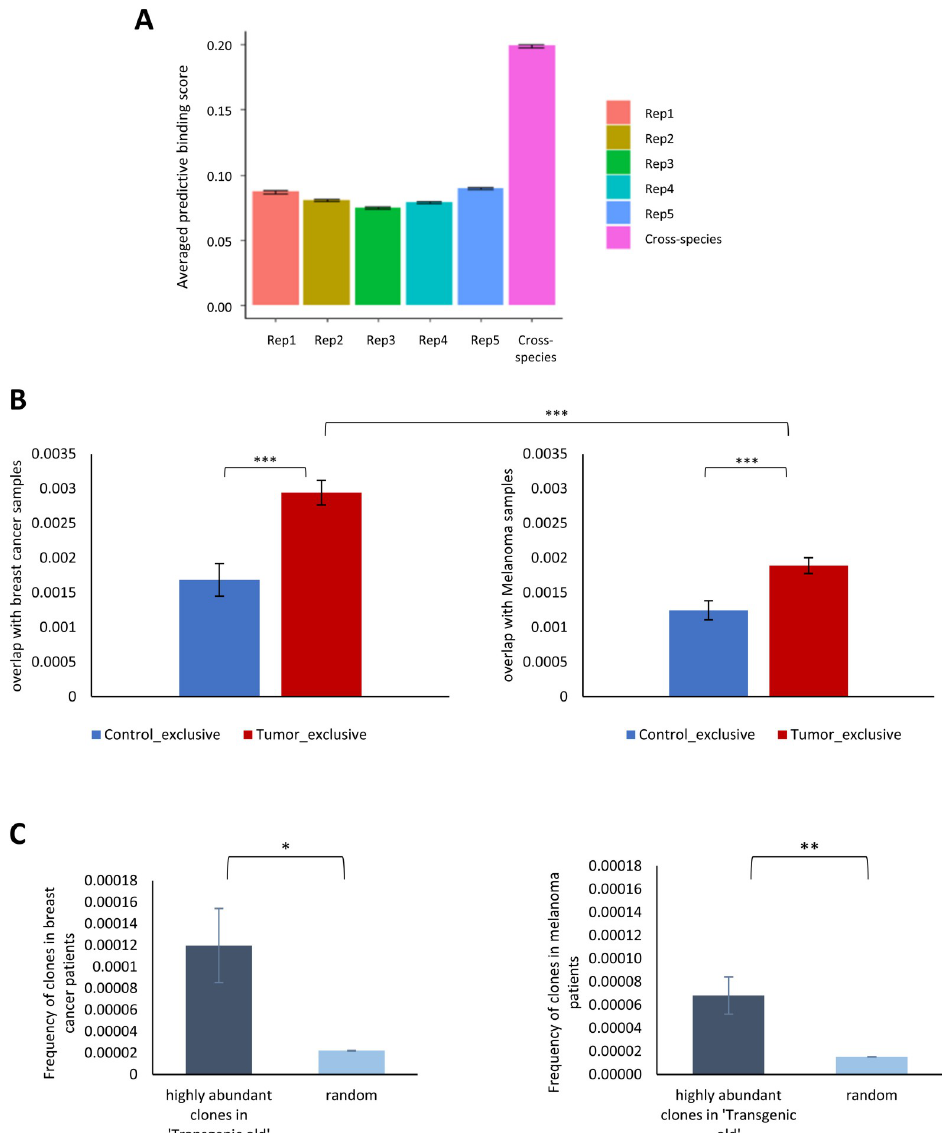
Fig 5. Cross-species tumor-associated clones. (A) The averaged predictive binding score to tumor peptides of tumor- associated cross-species sequences (right bar) and 5 random subsets of sequences. (B) The averaged Jaccard overlap index between control-exclusive sequences and tumor exclusive sequences to breast cancer samples (left plot) and Melanoma samples (right plot). (C) The frequency of highly abundant sequences from ‘Transgenic Old’ samples and random sequences in breast cancer samples (left plot) and melanoma samples (right